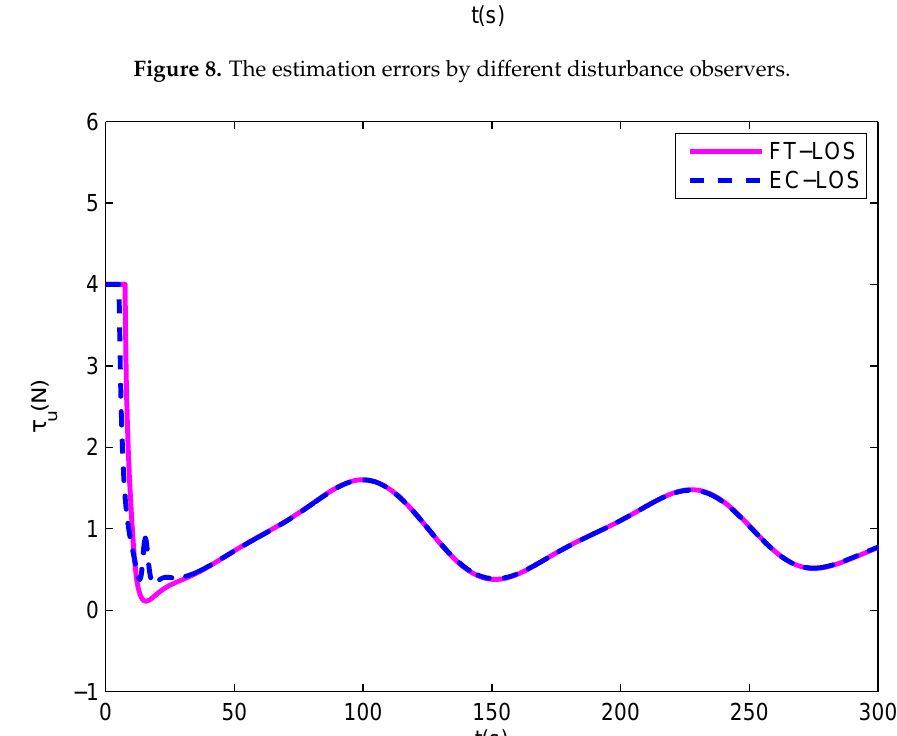
Figure 9. The surge force τ u under the input